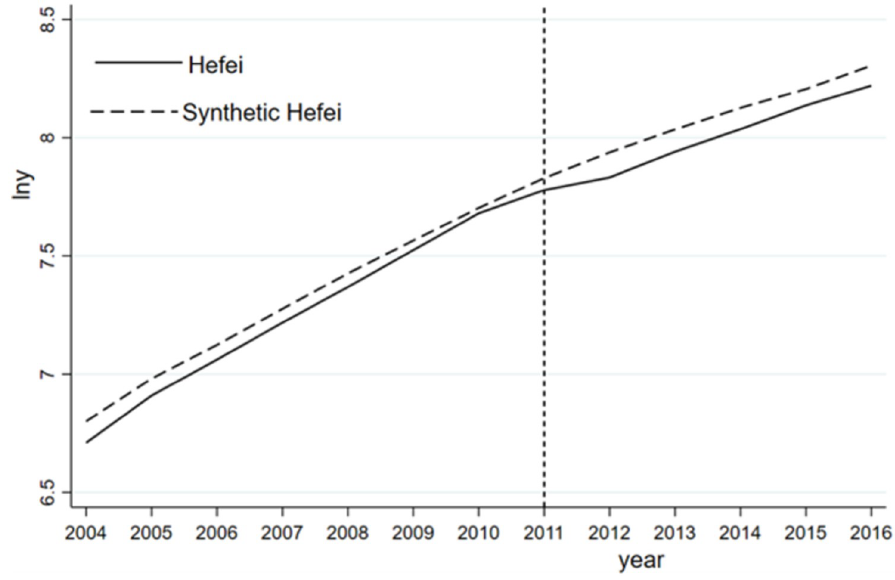
Fig 11. Log (GDP) of Hefei and synthetic